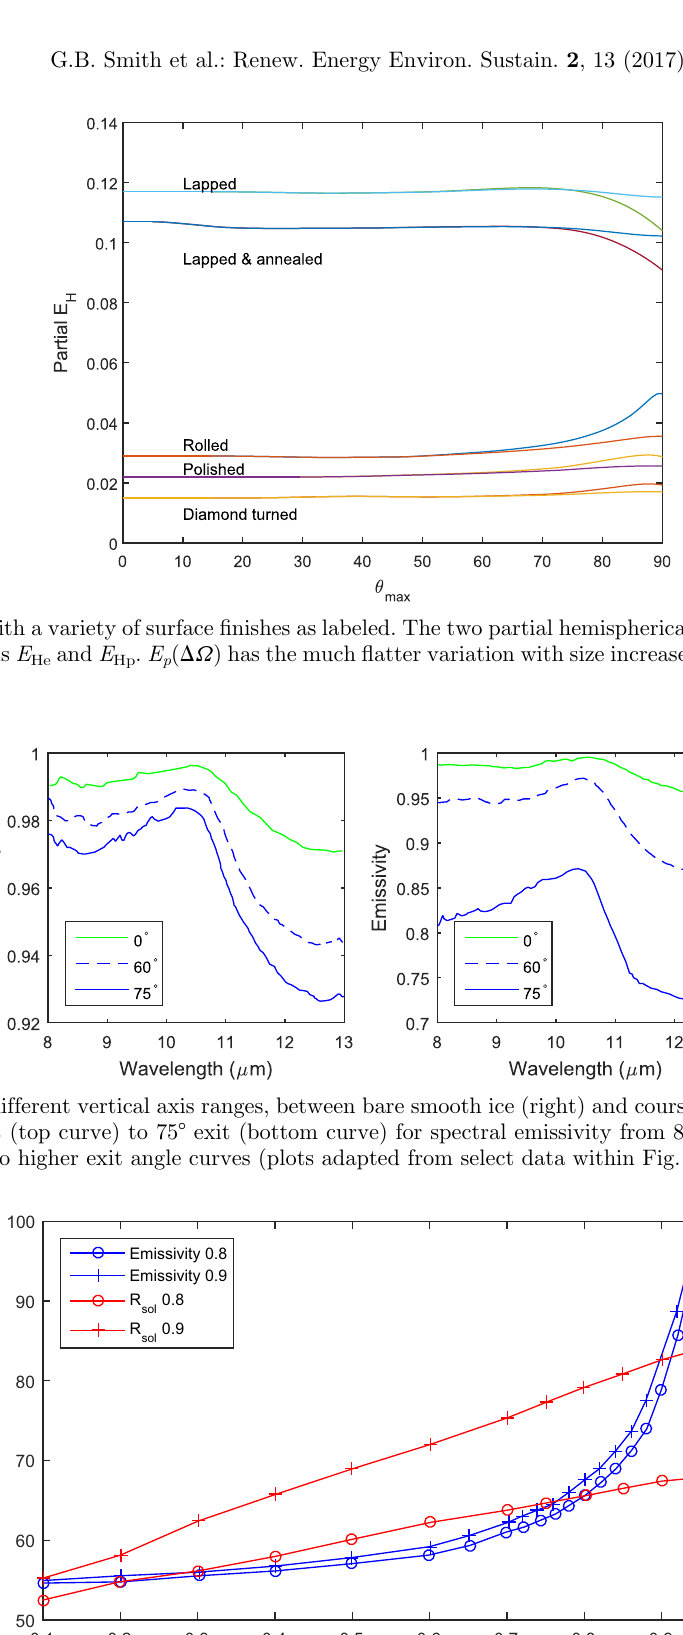
0.1 Albedo or Hemispherical Emittance Fig. 6. Plots showing the percentage of time in an average year in Sydney when surfaces will stay below ambient. With albedo of 0.9 and emittance above 0.8 it will do so more than 80% of the time while with this emittance range and albedo of 0.8 it does so in excess of 65% of elapsed